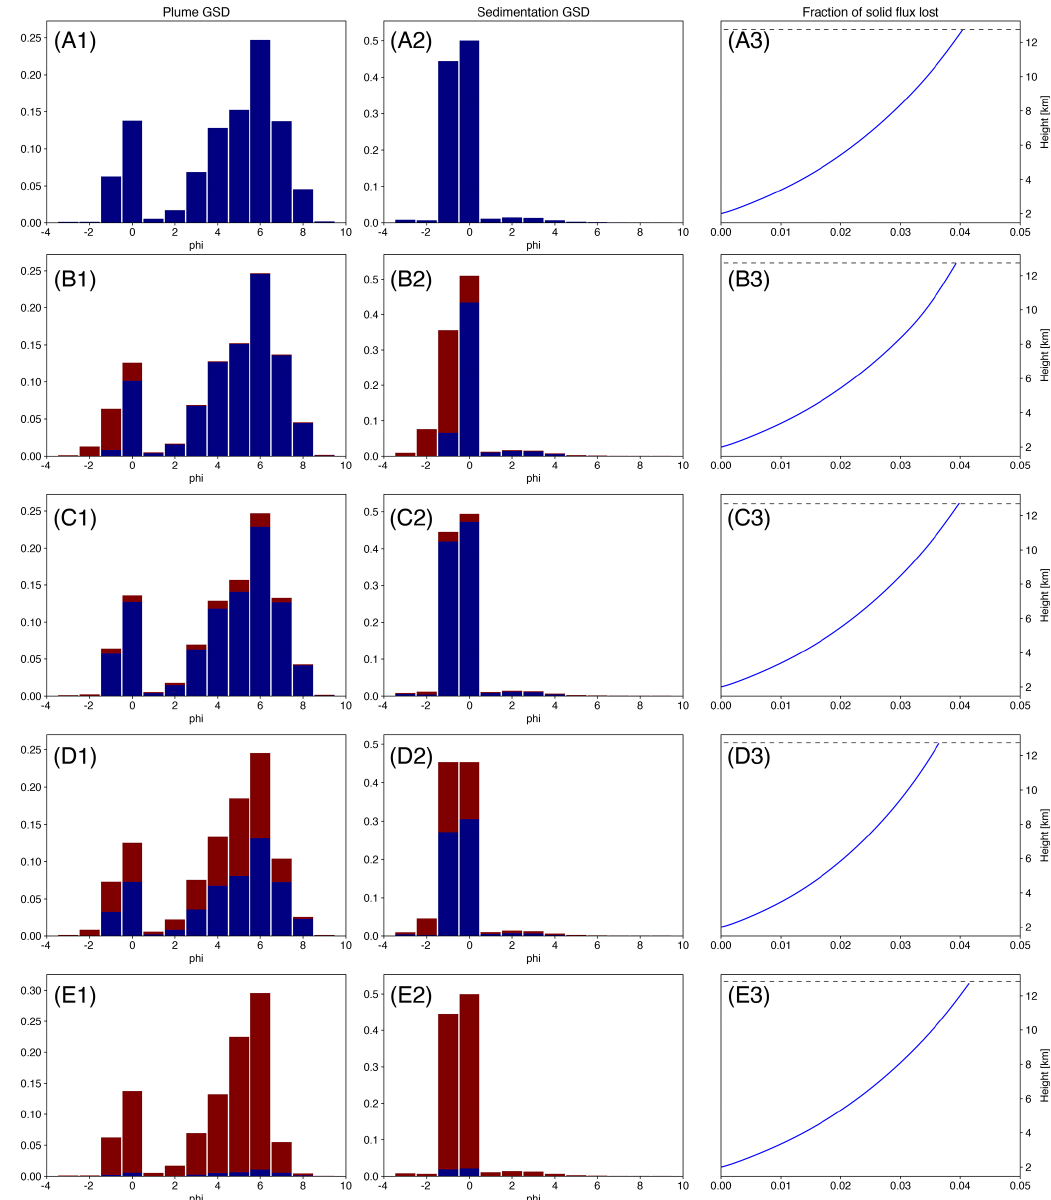
Figure 9. Grain size distributions at the neutral buoyancy level: within the plume (left panels) and released from the plume margins (central panels). The blue bars represent the number of non-aggregated particles, while the maroon bars represent the number of aggregates. The plot on the right panels represent the fraction of solid flux lost from the plume margins because of sedimentation, up to the neutral buoyancy level (represented by the dashed black lines). The results of the simulation without aggregation are plotted in panels (A1) and (A2) . The results obtained with the wet aggregation model presented in Costa et al. (2010) are plotted in panels (B1) and (B2) . The results obtained with a constant aggregation kernel and values of 10 − 15 , 10 − 14 , and 10 − 13 are plotted in panels (C1–C3) , (D1–D3) , and (E1–E3) ,